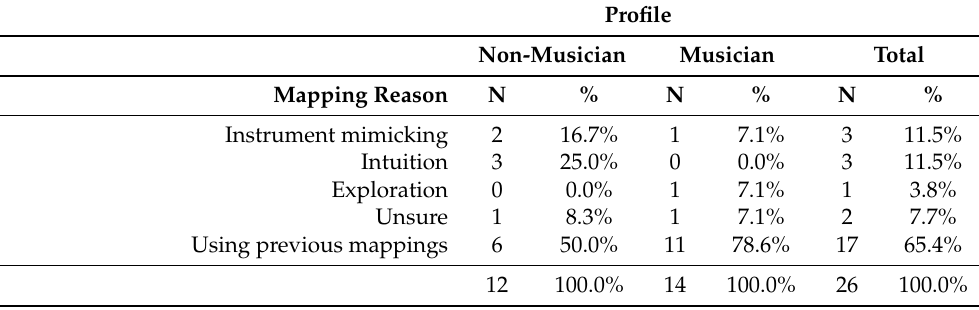
Table A21. Mapping rationale—stimulus